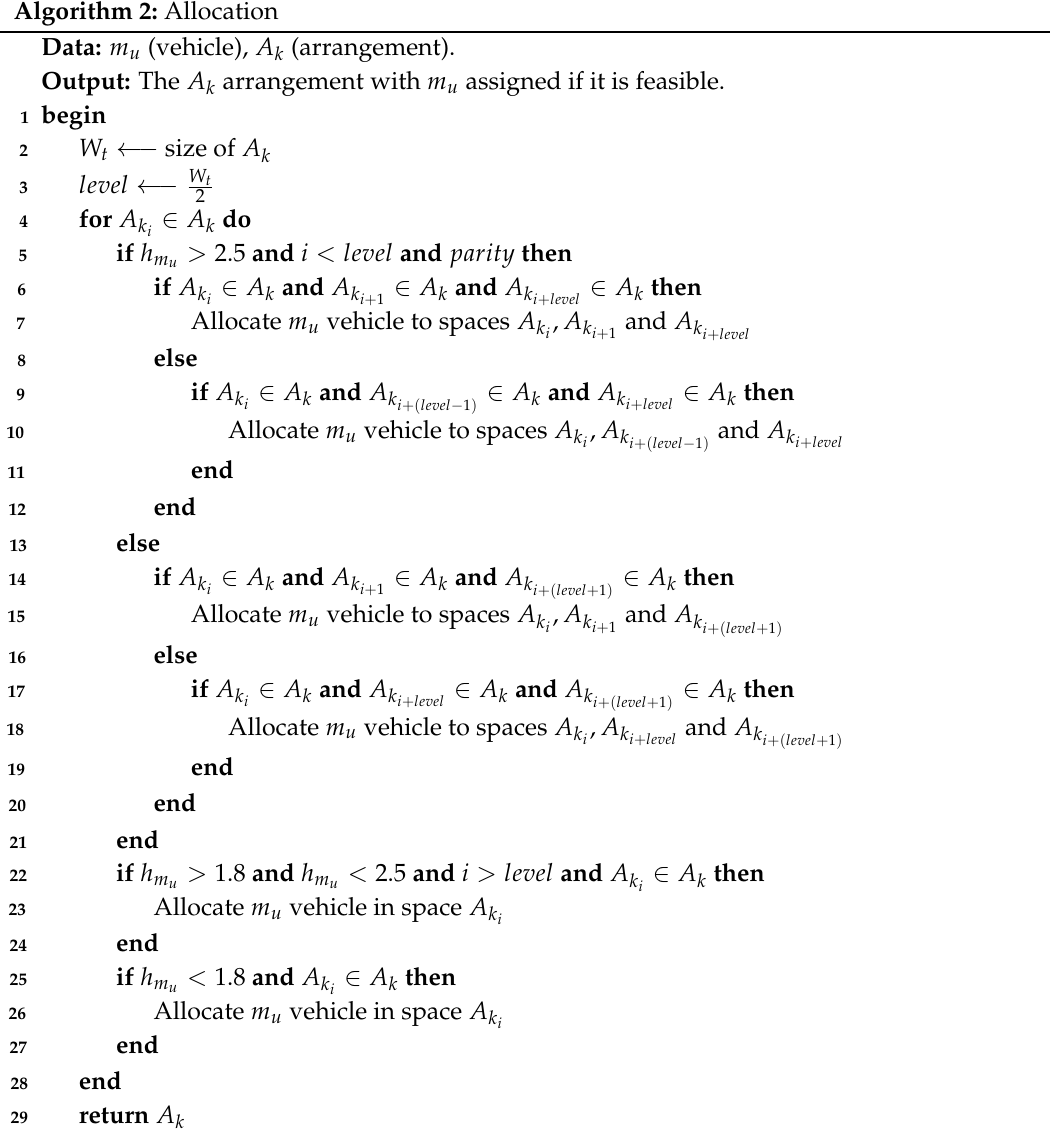
Algorithm 2: Allocation Data: m u (vehicle), A k